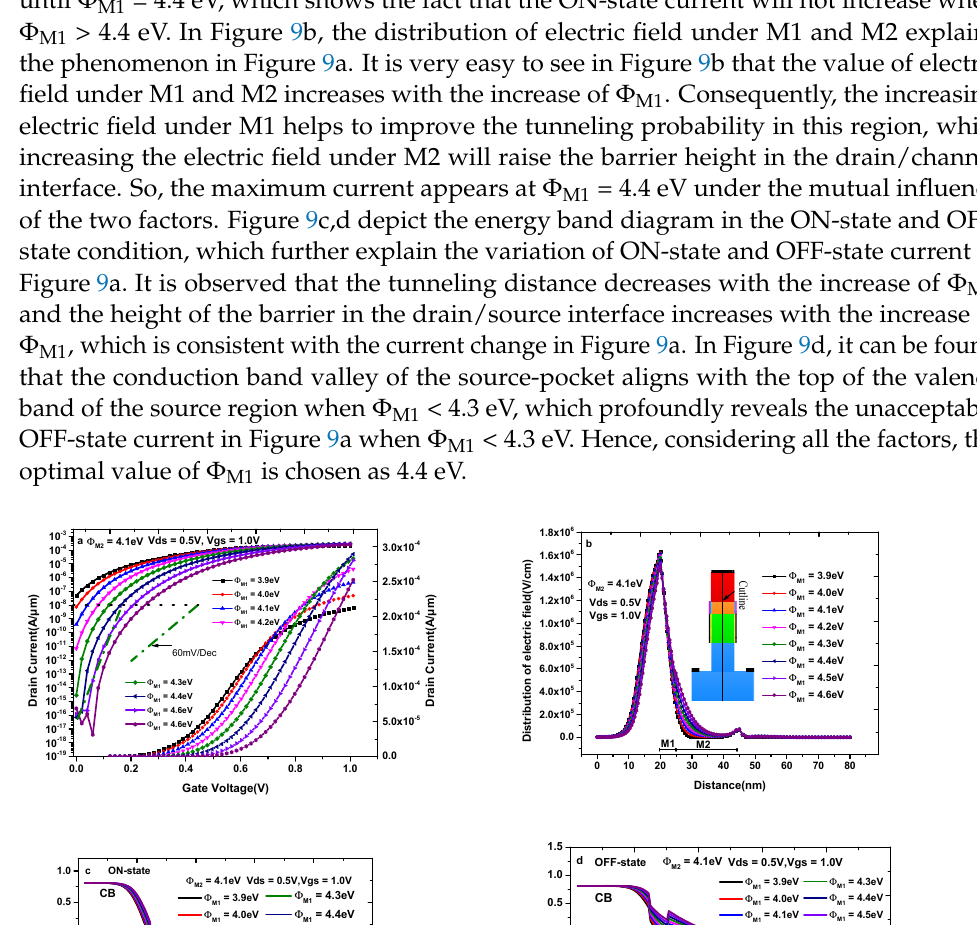
12 of 17 Figure 8. ( a ) Transfer characteristics of DMG-HD-VTFET with different source-pocket concentra- tion; ( b ) the variation of ON-state current and average subthreshold swing (SSave) with different source-pocket concentrations. As mentioned in the Introduction, the gate electrode of DMG-HD-VTFET is divided into two parts, namely the tunnel gate (M1) and the control gate (M2) with work func- tions Φ M1 and Φ M2 ; correspondingly, HfO 2 and SiO 2 are adopted under M1 and M2. Next,